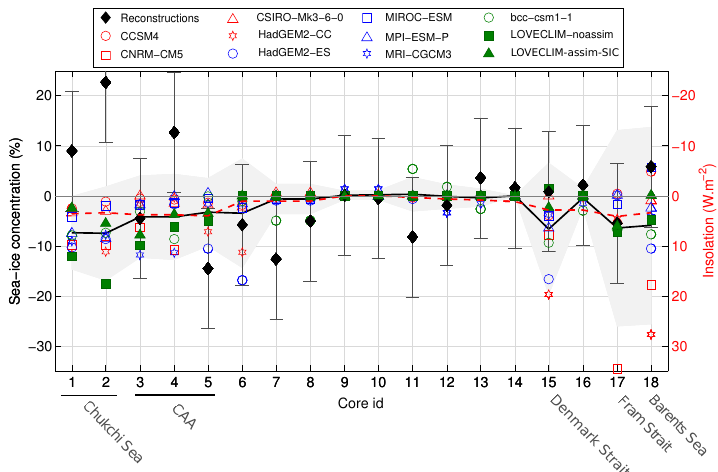
Figure 3. Mid-Holocene annual mean sea ice concentration anomalies (in %) for the proxy-based reconstructions of de Vernal et al. (2013a) (black diamonds with error bars) and the corresponding climate models results. The thick black line is the model mean. The grey shaded areas are the model mean ± 2 standard deviations. The dashed red line represents the annual mean insolation at each location studied (in Wm − 2 ) and corresponds to the reversed right axis. The reference period is AD1850–1900.